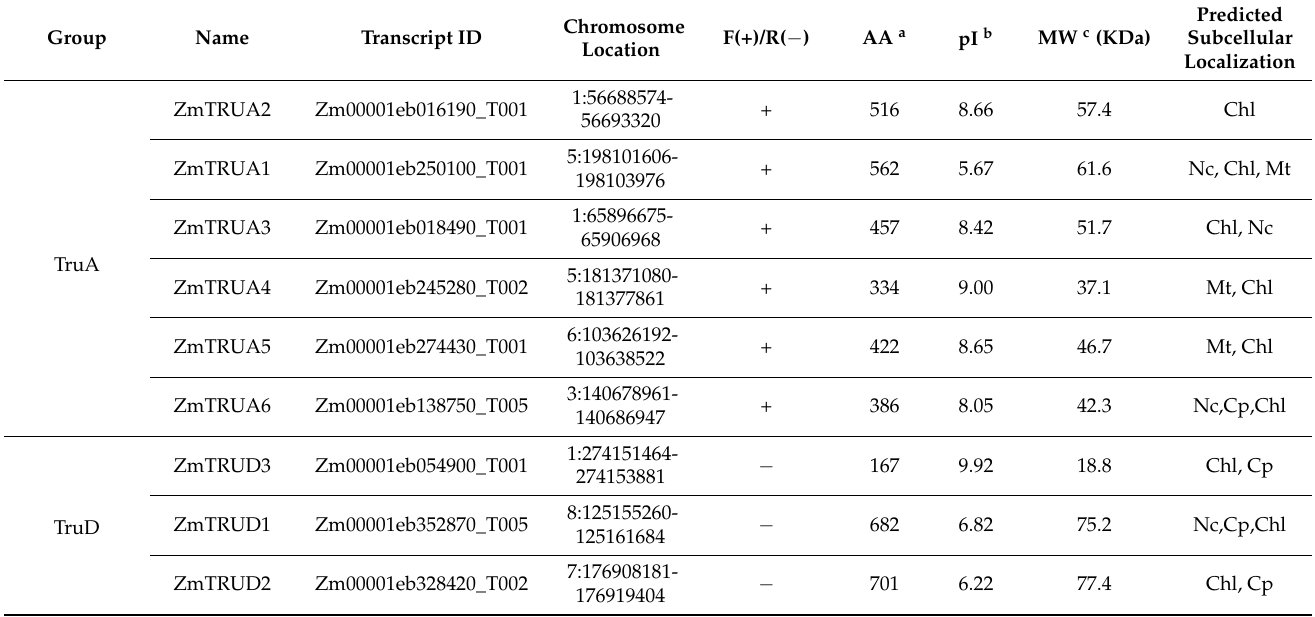
Table 2. Information of ZmPUS genes and the predicted proteins in